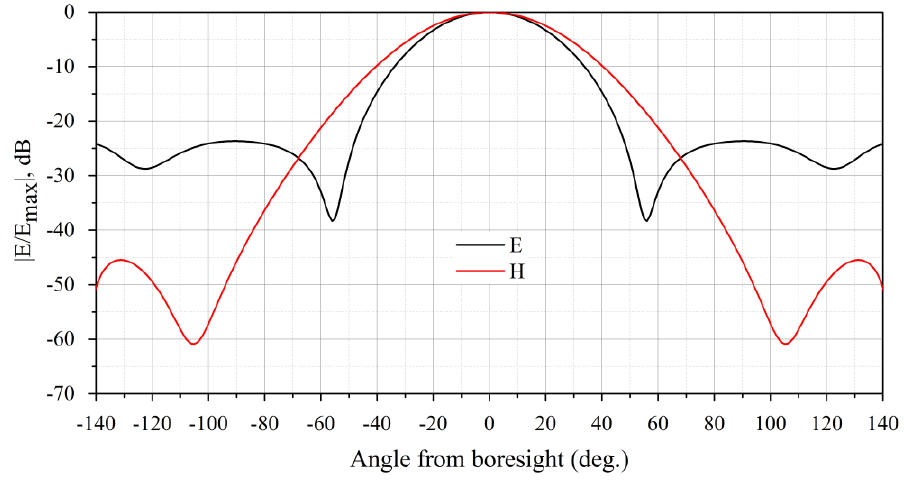
Fig. 4. Cavity antenna pattern